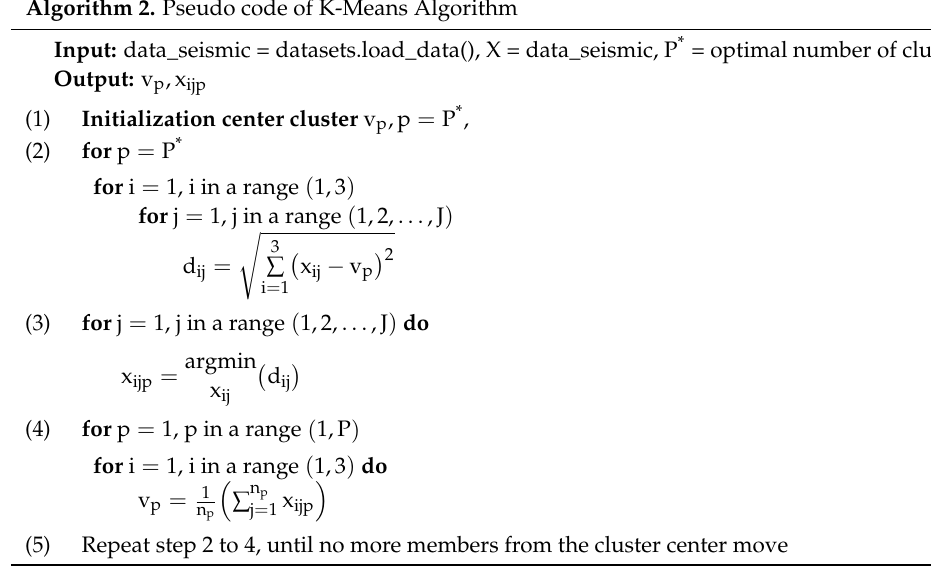
Figure 2. Selection of the optimal number of clusters using the elbow method